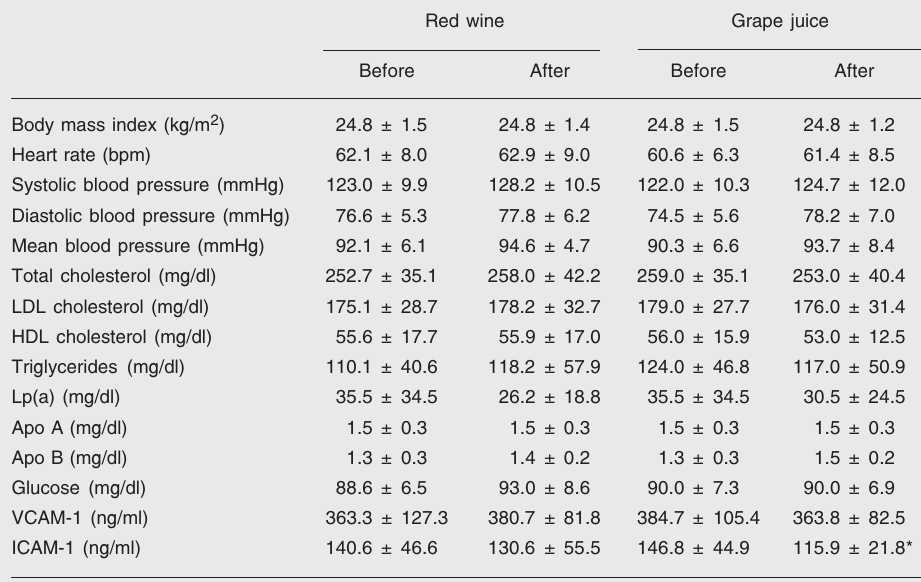
Table 1. Characteristics of hypercholesterolemic patients at baseline and after the ingestion of red wine or grape juice. Red wine Grape